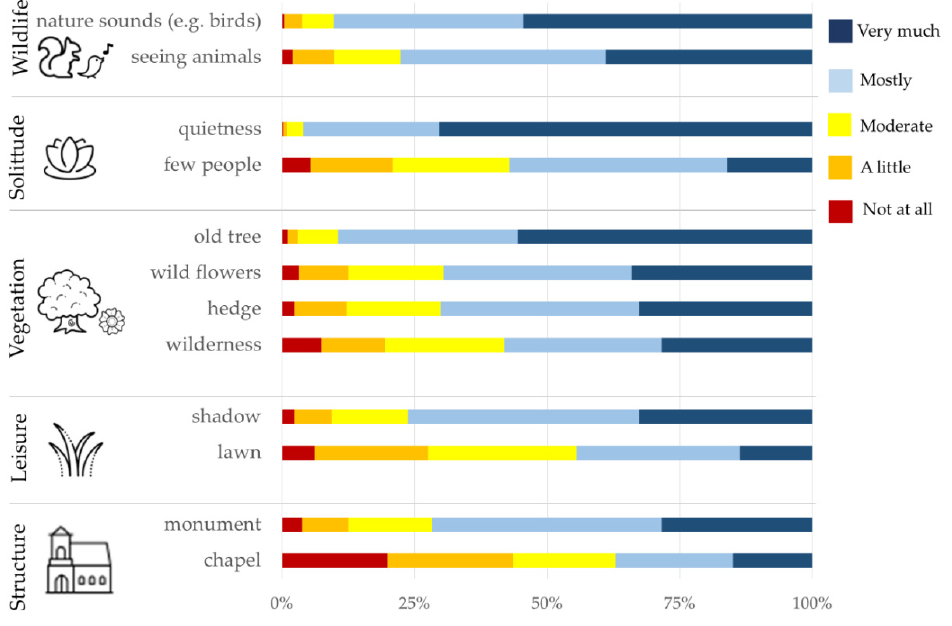
Figure 3. Items within each cemetery characteristic category (from most to least preferred). Procentual rating of importance per item from 1 (red = ‘not at all’) to 5 (blue = ‘very much’). Comparing preferences for the five overarching cemetery features, we found signif- icant differences ( p < 0.001, Wilcoxon rank sum test with Bonferroni correction); except for wildlife (mean = 4.23, SD ± 0.82, median = 4.5), followed by solitude (mean = 4.06, SD ± 0.7, median = 4.0), and vegetation (mean = 3.94, SD ± 0.83, median = 4.0), leisure (mean = 3.61, SD ± 0.86, median = 3.5), and structure (mean = 3.36, SD ± 1.0, median =